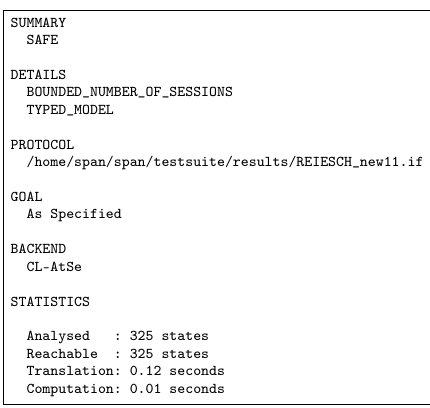
Figure 16. Simulation result using